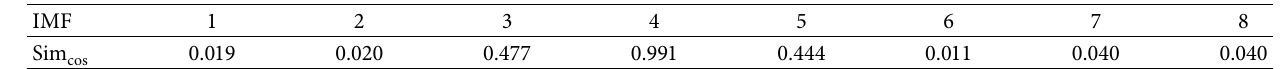
Figure 10: First eight IMFs of the 3rd vibration signal (from high- to low-frequency bands). Table 6: Results of cosine similarities based on the first selected raw data.